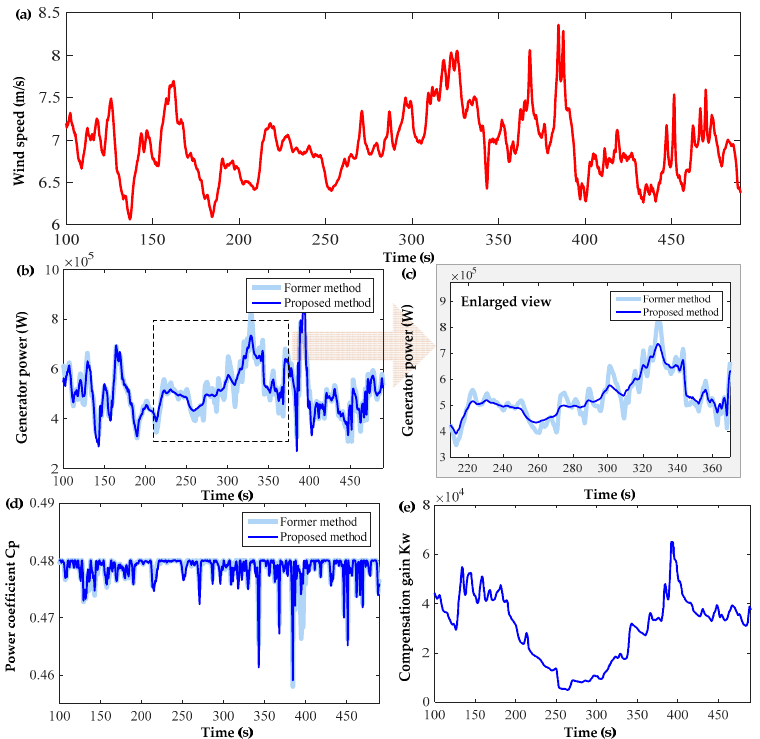
Figure 13. Simulation results under different wind fluctuations, ( a ) wind speed; ( b ) generator power; ( c ) enlarged view of generator power; ( d ) conversion efficiency; ( e ) compensation gain.